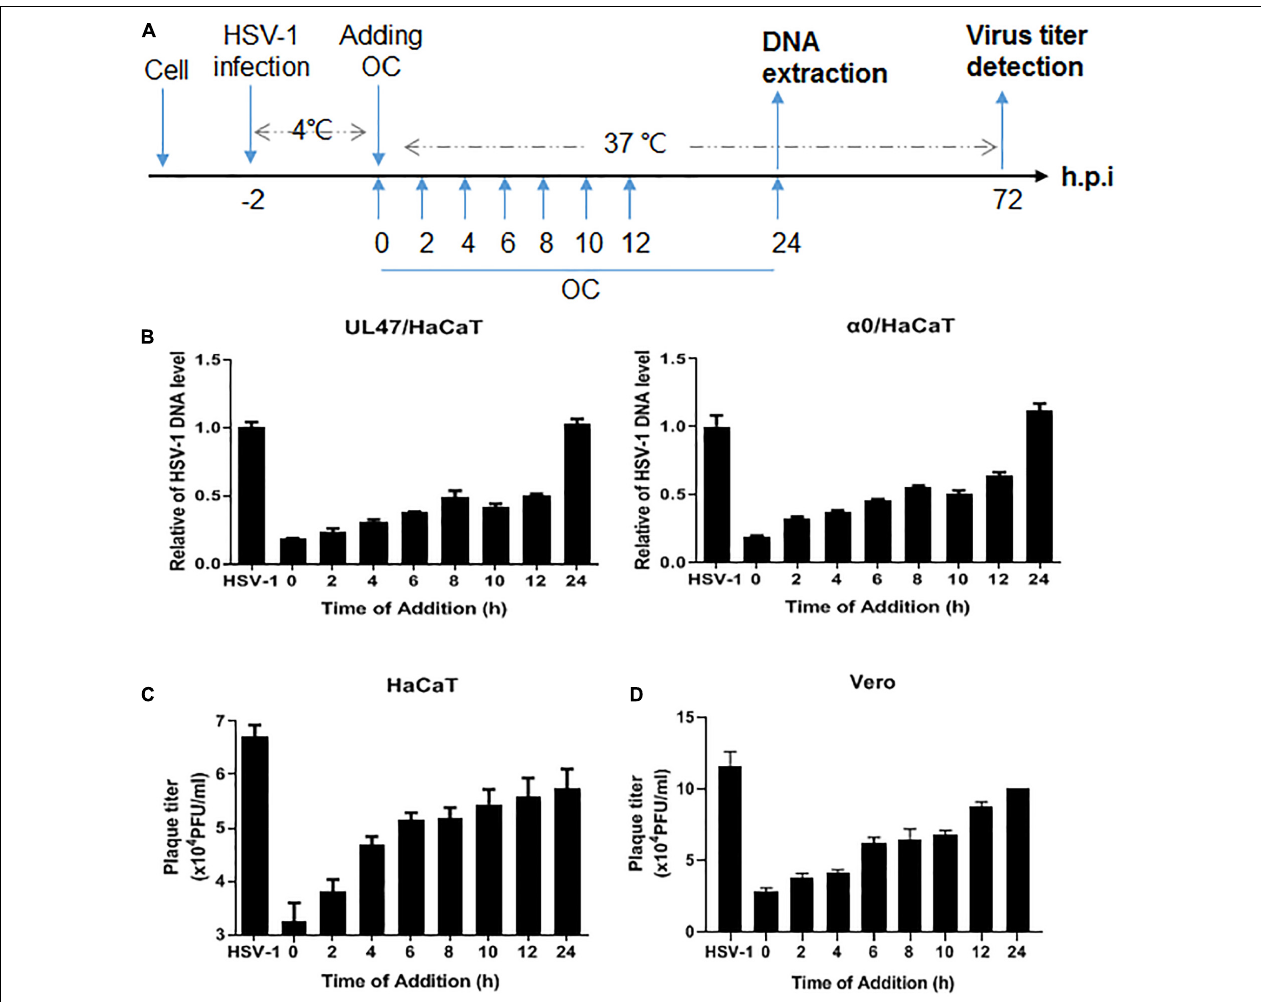
FIGURE 3 | Oleanolic acid affects viral early infection. (A) Simple diagram of the time-of-addition assay. (B) HaCaT cells infected with HSV-1 (MOI = 1) at 4 ◦ C for 2 h were washed with PBS and incubated at 37 ◦ C. Oleanolic acid were added at indicated time points. After 24 h, total viral DNA was extracted and the DNA copy numbers of viral gene α 0 and UL47 were detected by qRT-PCR. (C,D) HaCaT and Vero cells were infected with HSV-1 (MOI = 1) at 4 ◦ C for 2 h, and were washed with PBS to remove the virions. The cells were then incubated at 37 ◦ C and were treated with Oleanolic acid at indicated time points. After 72 h, the supernatant of cell culture was collected to perform viral titration assay and calculate viral titers. Data are mean ± SD ( n =